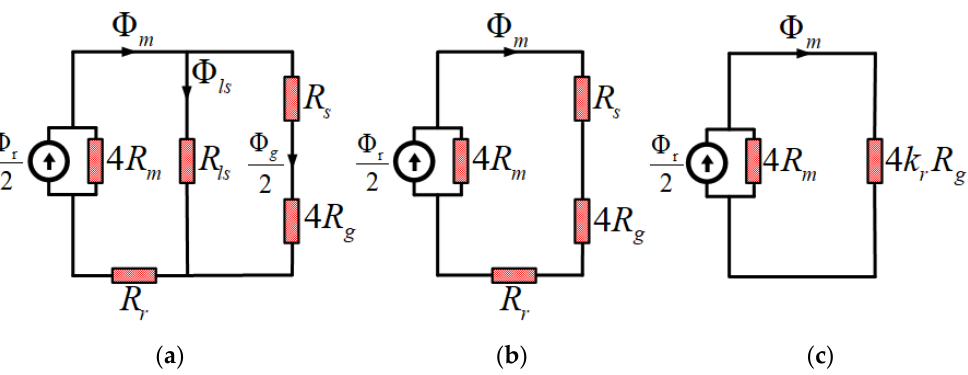
Figure 2. Simplification of MEC model: ( a ) sum of air gap reluctance; ( b ) MEC with leakage factor applied; ( c ) MEC with iron core’s reluctance factor applied.